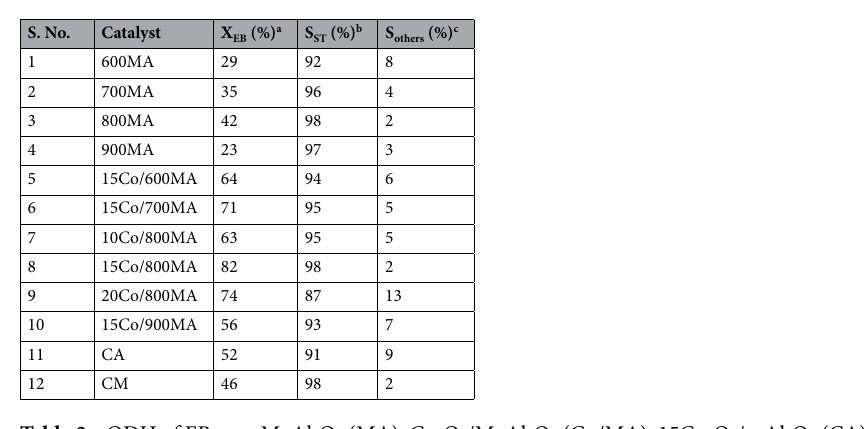
Table 3. ODH of EB over MgAl 2 O 4 (MA), Co 3 O 4 /MgAl 2 O 4 (Co/MA), 15Co 3 O 4 /γ-Al 2 O 3 (CA), and 15Co 3 O 4 / MgO (CM) samples in CO 2 atmosphere. a X EB = conversion of EB. b S ST = selectivity of ST. c S others = selectivity of other by-products. *Reaction conditions: Catalyst = 0.7 g, T = 600 °C, CO 2 flow = 30 mL/min, EB flow = 1.5